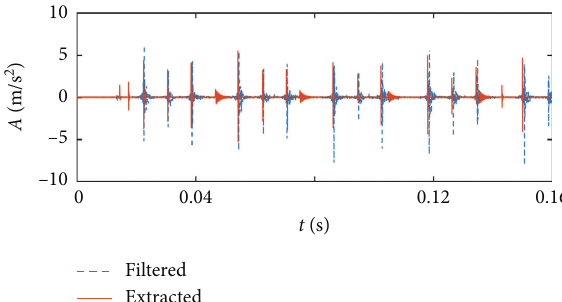
Figure 12: Filtered noiseless signal and extracted feature signal under 5 dB noise condition with single-cylinder misfire